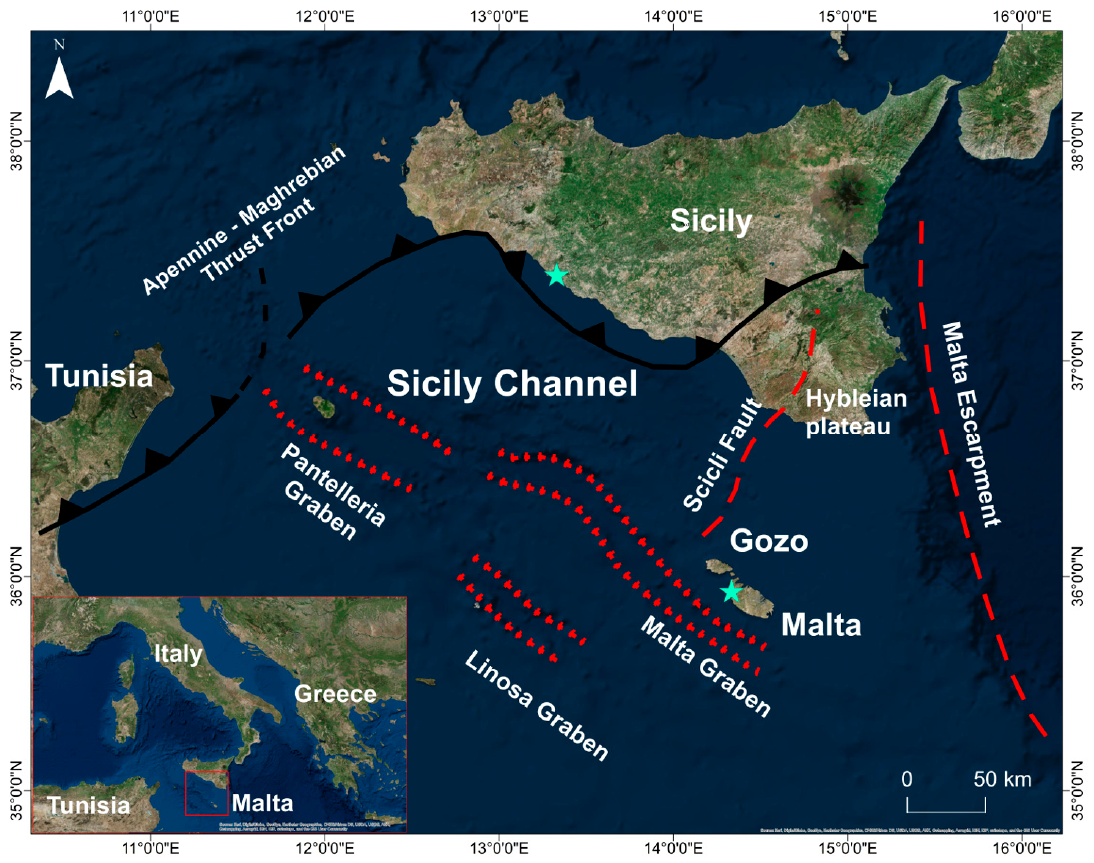
Figure 1. Location map of the study areas showing the principal structural features (cf. [25,27]).